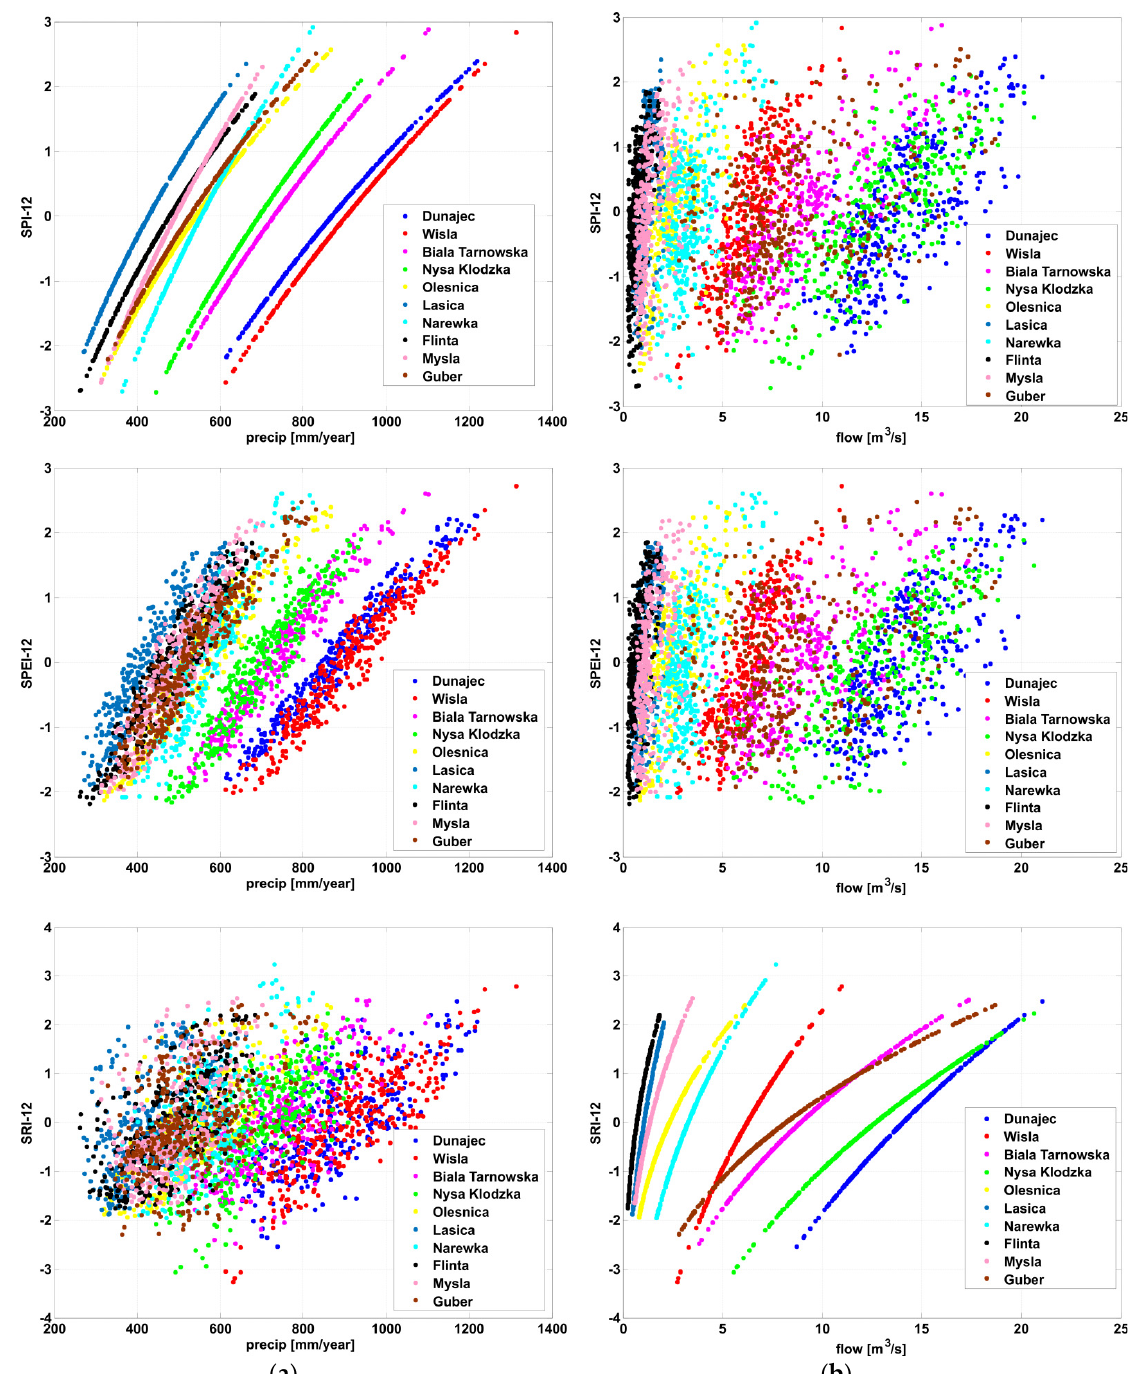
Figure 3. Scatterplots showing dependency between accumulated annual precipitation ( a ), mean annual daily flow ( b ) and three studied drought indices (SPI-12, SPEI-12 and SRI-12) for ten catchments.